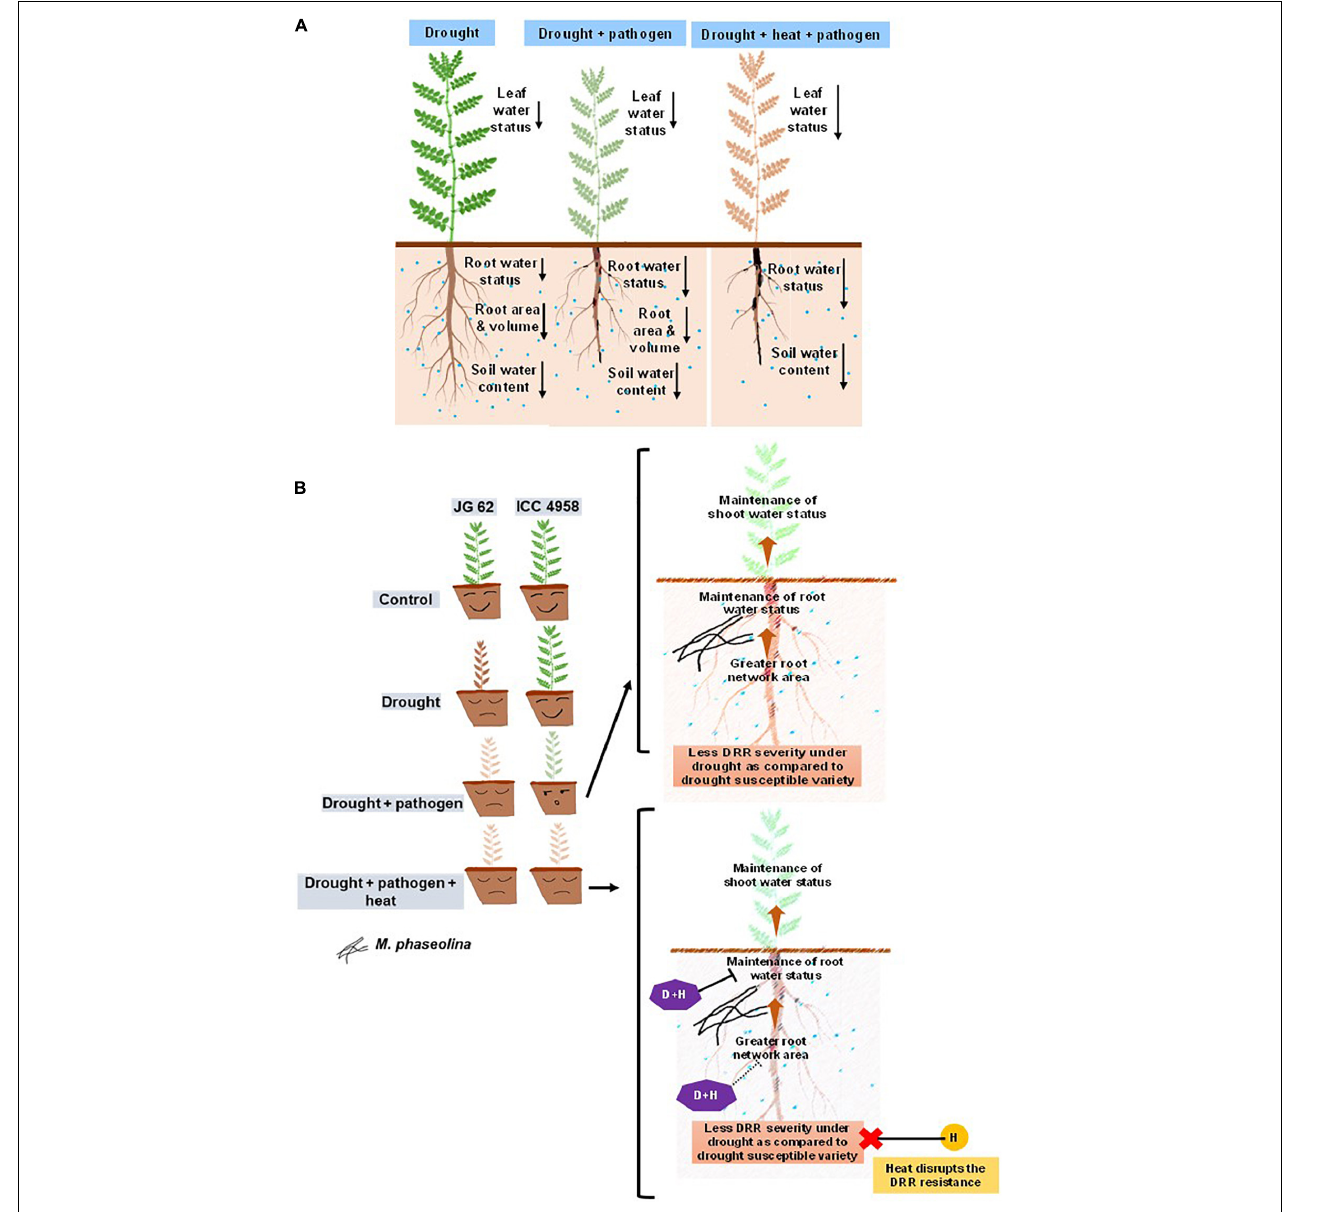
FIGURE 6 | Schematic summary showing the effect of drought and heat on chickpea water relations and response to DRR. (A) Illustration comparing the effect of individual drought, drought + pathogen, drought + pathogen + heat on water relations of chickpea. Both drought-only and combined drought and pathogen treatments reduce the root and leaf water content apparently due to reduction in the root-associated traits like network area, volume, and length. Enhanced transpiration under heat stress further reduces the root water status. The differences in the leaf and root water status, root architectural traits, and soil water content in the three treatments are indicated by black-colored arrows. The length of the arrows represents the extent of reduction (the longer the arrows, the more are the reductions). (B) Schematic representation of the possible mechanisms by which heat can reduce the resistance of a drought-tolerant variety to DRR. The left-hand side panel indicates the differential response of a drought-tolerant and susceptible variety to drought, pathogen, and combination of drought, heat, and pathogen. Whereas ICC 4958 can resist DRR infection better under drought conditions, heat makes it significantly susceptible to DRR. The right-hand panel represents the possible mechanism behind the same. A combination of pathogen and heat stress additively reduces the plant water content and disrupts the resistance to DRR shown by ICC 4958 under drought stress conditions. We hypothesize that drastic reduction in root water content mediated by heat may be one of the primary physiological processes behind the loss of resistance of ICC 4958 under heat stress. Broken arrows exhibit a predicted observation warranting future investigations. P, pathogen stress; H, heat stress, D + H, combined drought and heat stress. In panel (A) , the colors of the shoots represent the effect of soil water deficit and pathogen infection on plants. Since M. phaseolina is a root infecting pathogen, symptoms are not very visible in shoots. A combination of drought and DRR pathogen leads to enhanced disease and reduced shoot water status indicated by the faded color of the shoots. The combination of heat, drought, and pathogen causes further additive reductions in leaf water status and an increase in disease severity which is indicated by the brown coloration of the shoot showing the maximum deleterious effect of the triple stress combination.